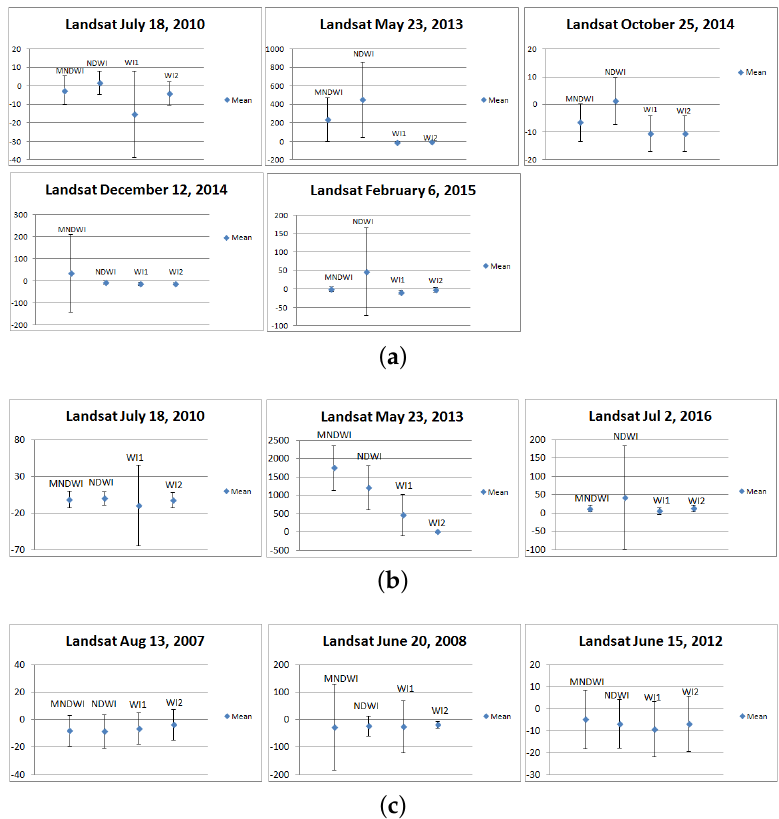
Figure 20. Mean distance and standard deviation graphs between the high resolution data and the original Landsat resolution images (30 m/pixel) in the study sites for accuracy validation. ( a ) The statistic results in the coastline detected in the Guadalfeo delta river. ( b ) The statistic results in the coastline detected in the Adra delta river. ( c ) The statistic results in the coastline detected in the Ebro delta